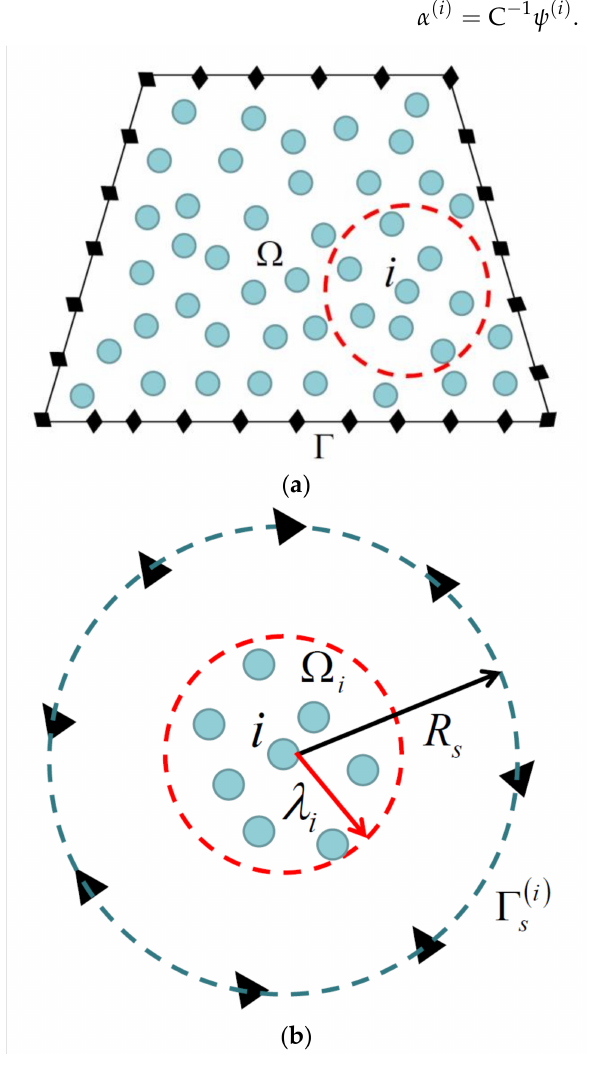
Figure 1. The schematic diagram for ( a ) the computational domain, boundary, and distribution of nodes and ( b ) the subdomain of